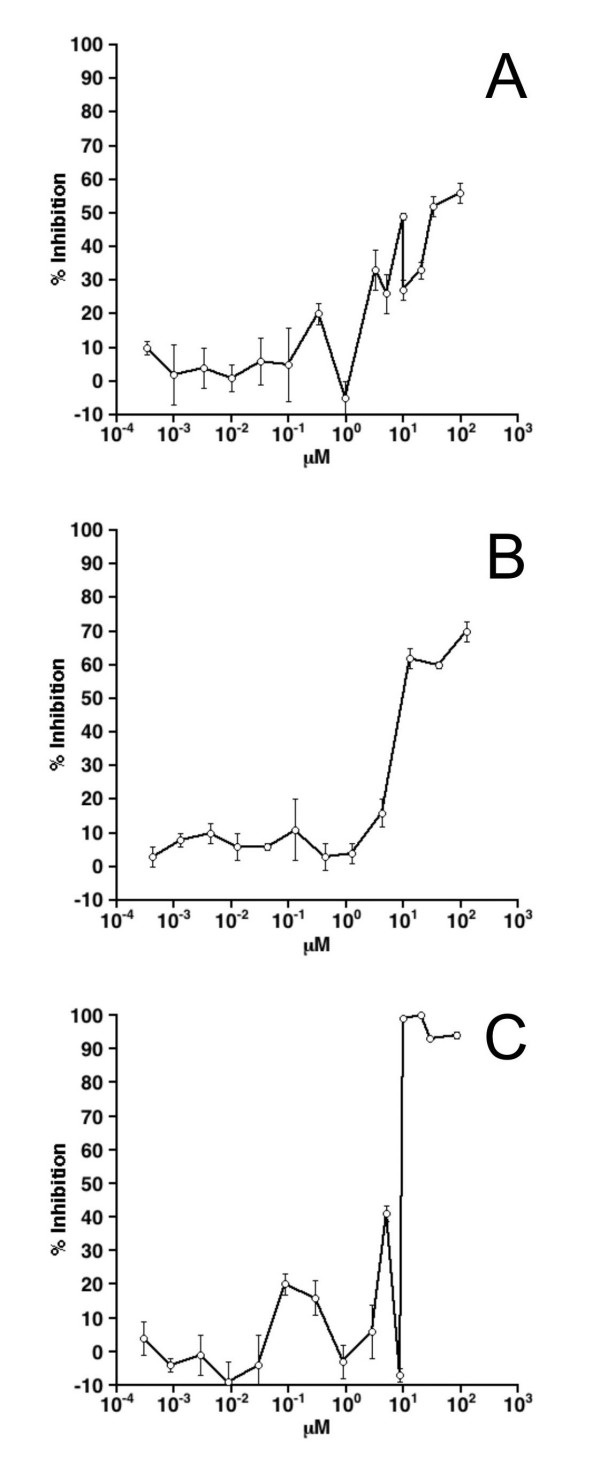
Dose-response curves for WN53, WN83 and DN59 peptides. (A) Increasing concentrations of peptide WN53 produce a corresponding increase in WNV inhibition with an IC50 in the 10μ range. (B) Increasing concentrations of peptide WN83 produce a corresponding increase in WNV inhibition with an IC50 in the 10 μM range. (C) Increasing concentrations of peptide DN59 also produce a corresponding increase in DNV inhibition with an IC50 in the 10 μM range. All measurements were made in triplicate, with mean +/- SD shown.